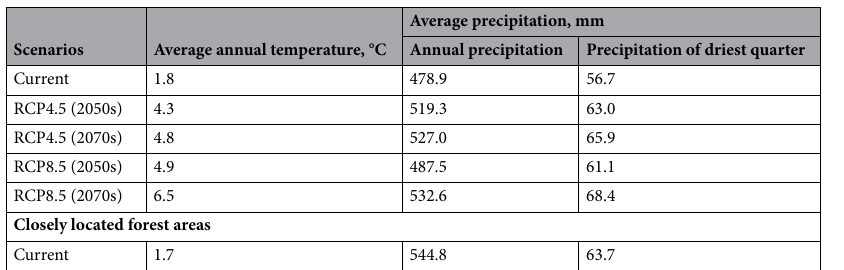
Table 1. Average temperature and precipitation in the Southern Urals mountain forest-steppe locations of Patrinia sibirica at present and under different climate change scenarios and the current climatic parameters in closely located